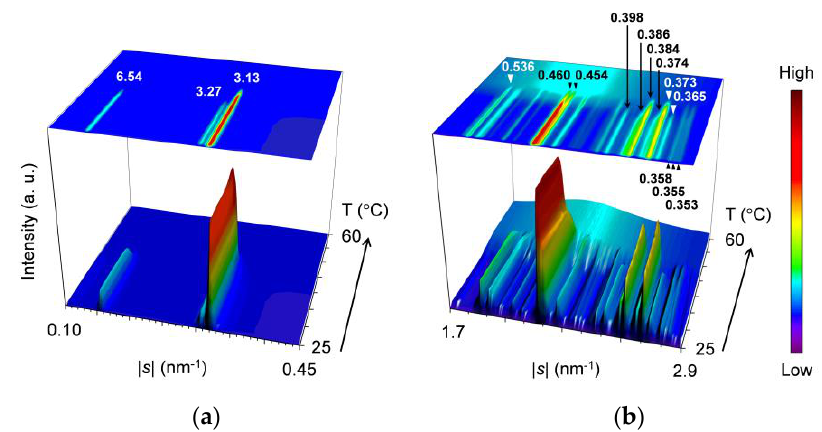
Figure 6. Topographic plots of the SR-XRD data for 25 °C-aged SOS/LLL ( w LLL = 0.667), taken during heating at a rate of 5 °C/min: ( a ) SAXS; and ( b ) WAXS. Unit: nm.